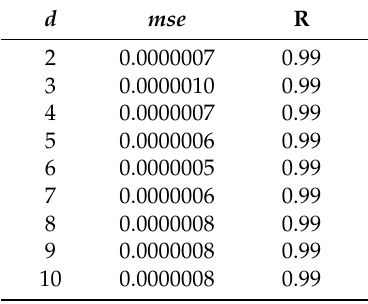
Table 1. Effect of the parameter d on the performance of training process for CO 2